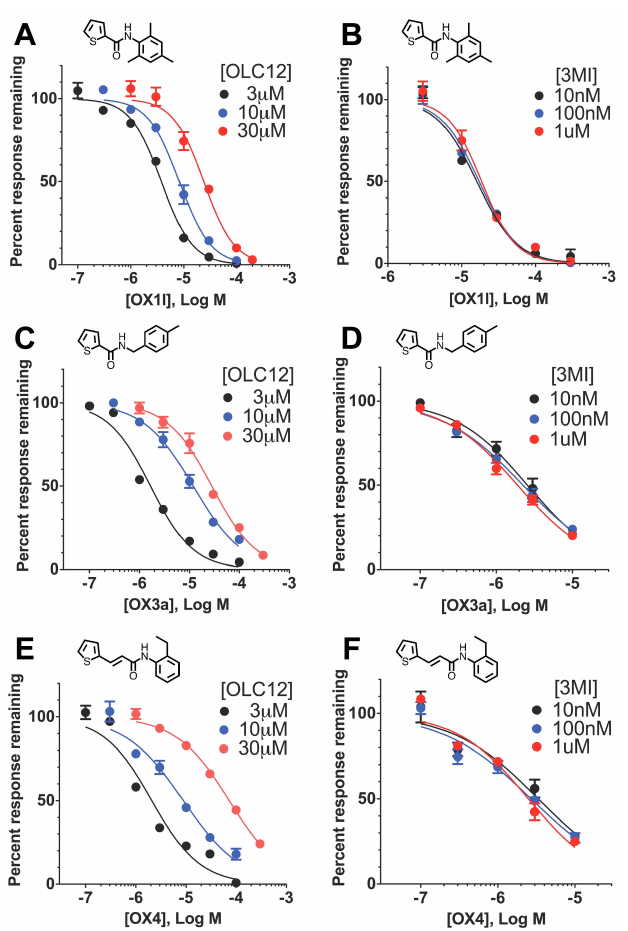
Figure 5. The potent Orco antagonists OX1l, OX3a and OX4 non-competitively inhibit odorant activation of a mosquito OR. A . Altering the concentration of Orco agonist (OLC12) shifts the OX1l inhibition curve. The IC for OX1l inhibition of Cqui\Orco 50 +Cqui\Or21 activation by 10 µM OLC12 (8.3 ± 0.5 µM, n = 4) is significantly different from the IC for OX1l inhibition of Cqui\Orco 50 +Cqui\Or21 activation by 3 µM OLC12 (3.8 ± 0.3 µM, n = 9) (p<0.0001, F-test). The IC for OX1l inhibition of Cqui\Orco+Cqui\Or21 50 activation by 30 µM OLC12 (24 ± 3 µM, n = 6) is significantly different from the IC for OX1l inhibition of Cqui\Orco+Cqui\Or21 50 activation by 3 µM OLC12 (p<0.0001, F-test) and from the IC for OX1l inhibition of Cqui\Orco+Cqui\Or21 activation by 10 µM 50 OLC12 (p<0.0001, F-test). B . Altering odorant (3MI) concentration fails to alter the inhibition curve for OX1l antagonism of Cqui \Orco+Cqui\Or21 activated by 3MI. The IC values for OX1l inhibition of responses to 10 nM 3MI (17 ± 1 µM, n = 3), 100 nM 3MI 50 (16 ± 1 µM, n = 3), and 1µM 3MI (19 ± 2 µM, n = 3) did not differ (p=0.3605, F-test). C . Altering the concentration of Orco agonist (OLC12) shifts the OX3a inhibition curve. The IC for OX3a inhibition of Cqui\Orco+Cqui\Or21 activation by 10 µM OLC12 (12 ± 1 50 µM, n = 3) is significantly different from the IC for OX3a inhibition of Cqui\Orco+Cqui\Or21 activation by 3 µM OLC12 (1.7 ± 0.2 50 µM, n = 4) (p<0.0001, F-test). The IC for OX3a inhibition of Cqui\Orco+Cqui\Or21 activation by 30 µM OLC12 (28 ± 2 µM, n = 3) is 50 significantly different from the IC for OX3a inhibition of Cqui\Orco+Cqui\Or21 activation by 3 µM OLC12 (p<0.0001, F-test) and 50 from the IC for OX3a inhibition of Cqui\Orco+Cqui\Or21 activation by 10 µM OLC12 (p<0.0001, F-test). D . Altering odorant (3MI) 50 concentration fails to alter the inhibition curve for OX3a antagonism of Cqui\Orco+Cqui\Or21 activated by 3MI. The IC values for 50 OX3a inhibition of responses to 10 nM 3MI (2.6 ± 0.3 µM, n = 3), 100 nM 3MI (2.3 ± 0.2 µM, n = 4), and 1µM 3MI (1.9 ± 0.1 µM, n = 3) did not differ (p=0.07, F-test). E . Altering the concentration of Orco agonist (OLC12) shifts the OX4 inhibition curve. The IC for 50 OX4 inhibition of Cqui\Orco+Cqui\Or21 activation by 10 µM OLC12 (8.8 ± 1.2 µM, n = 3) is significantly different from the IC for 50 OX4 inhibition of Cqui\Orco+Cqui\Or21 activation by 3 µM OLC12 (2.1 ± 0.3 µM, n = 5) (p<0.0001, F-test). The IC for OX4 50 inhibition of Cqui\Orco+Cqui\Or21 activation by 30 µM OLC12 (73 ± 5 µM, n = 3) is significantly different from the IC for OX4 50 inhibition of Cqui\Orco+Cqui\Or21 activation by 3 µM OLC12 (p<0.0001, F-test) and from the IC for OX4 inhibition of Cqui\Orco 50 +Cqui\Or21 activation by 10 µM OLC12 (p<0.0001, F-test). F . Altering odorant (3MI) concentration fails to alter the inhibition curve for OX4 antagonism of Cqui\Orco+Cqui\Or21 activated by 3MI. The IC values for OX4 inhibition of responses to 10 nM 3MI (3.4 ± 50 0.6 µM, n = 3), 100 nM 3MI (2.7 ± 0.4 µM, n = 3), and 1µM 3MI (2.5 ± 0.3 µM, n = 3) did not differ (p=0.42, F-test). doi: 10.1371/journal.pone.0084575.g005 PLOS ONE |